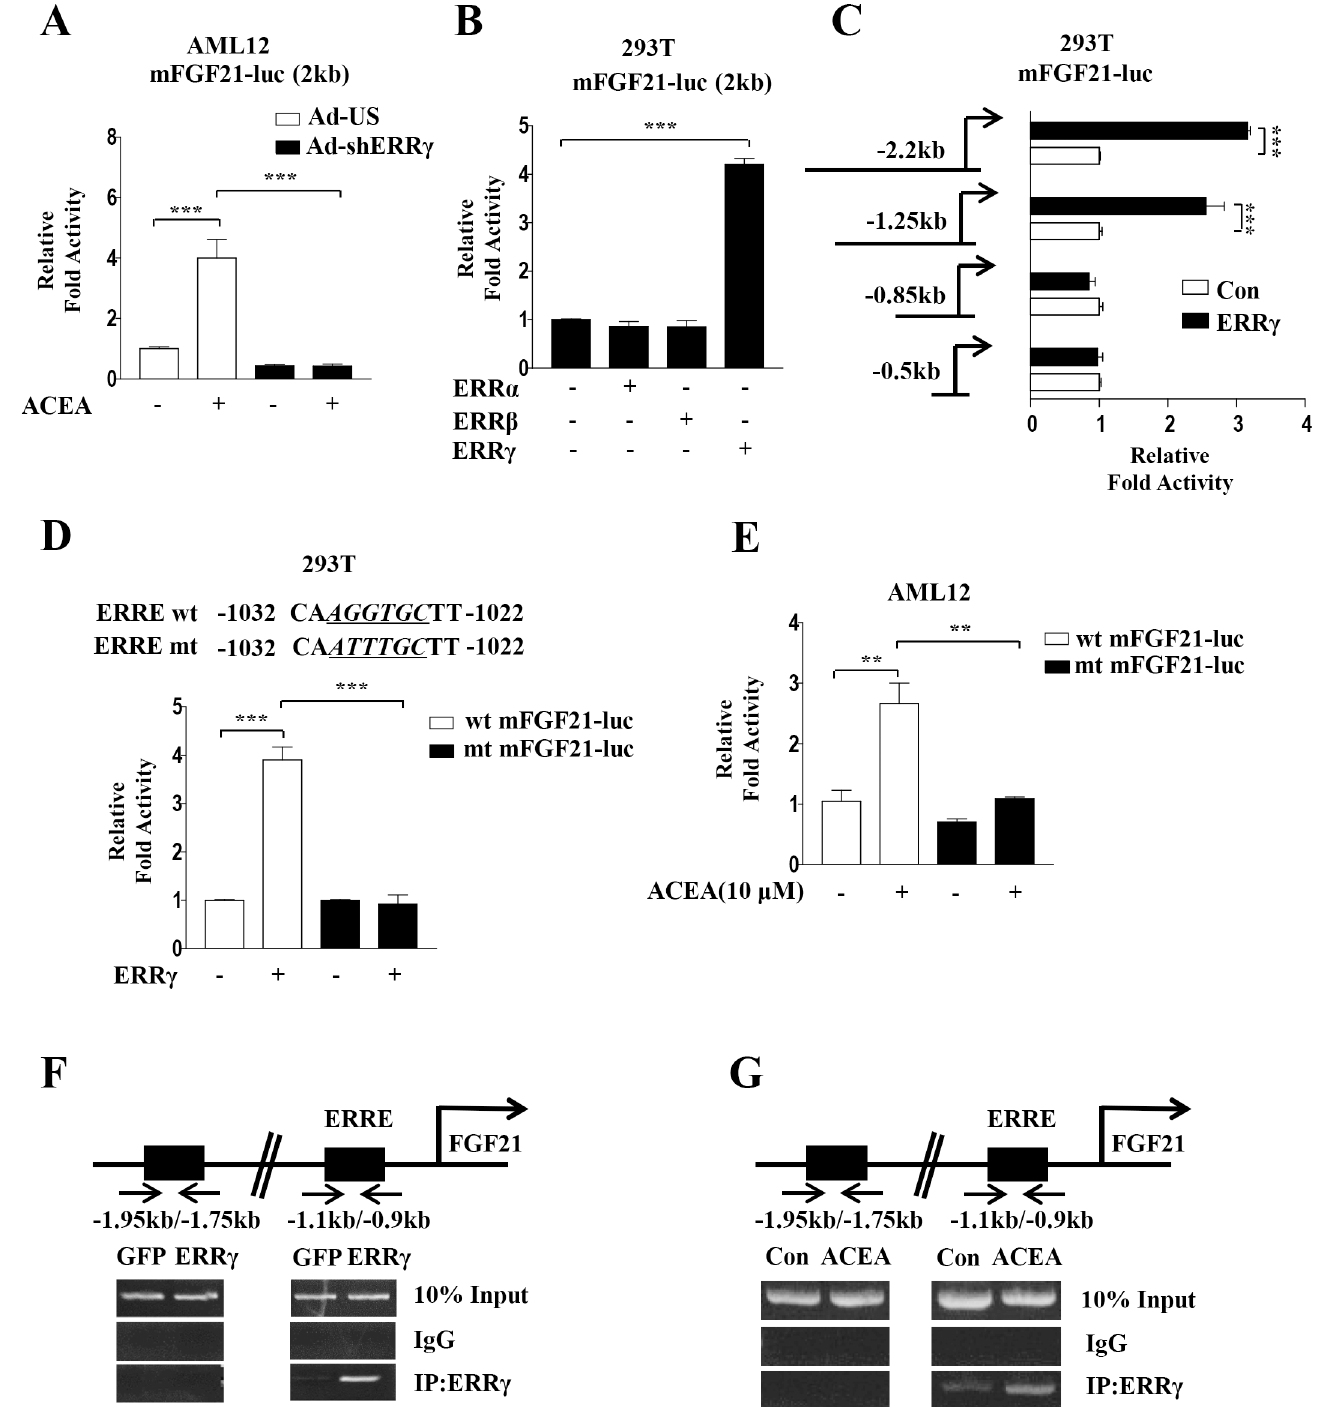
Fig 5. ERR γ activates mouse FGF21 gene promoter activity. (A) AML12 cells were transfected with mFGF21-Luc and then treated with ACEA for 3 h. (B) 293T cells were transfected with mFGF21-Luc along with expression vectors for ERR α , ERR β , and ERR γ . (C) 293T cells were co-transfected with deletion mutants of mFGF21-Luc and ERR γ . (D) 293T cells were co-transfected with mFGF21-Luc, mFGF21 ERRE mut-Luc, and ERR γ . The alignment of potential ERRE sequences in the human and mouse FGF21 promoters is shown (top). (E) AML12 cells were transfected with mFGF21-Luc or mFGF21 ERRE mut-Luc and treated with ACEA for 3 h. (F-G) ChIP assay analysis was performed with Ad-GFP- or Ad-ERR γ - infected AML12 cells and ACEA treated AML12 cells. Cell extracts were immunoprecipitated with an anti-ERR γ antibody. Purified DNA samples were employed for PCR with primers that bind to the ERRE (-1.1 kb to -0.9 kb) and a distal site (-1.95 kb to -1.75 kb) in the FGF21 gene promoter. All data are the means ± standard errors of at least three independent experiments. ** p < 0.01; *** p < 0.001 by one-way ANOVA. doi:10.1371/journal.pone.0159425.g005 PLOS ONE | DOI:10.1371/journal.pone.0159425 July 25,